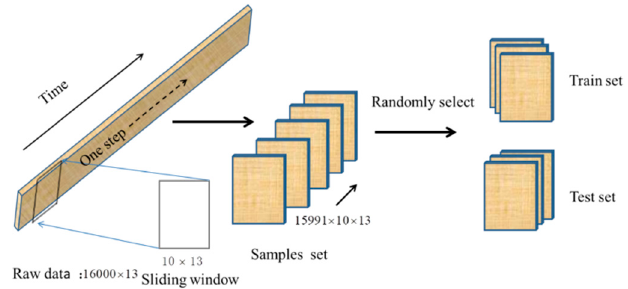
Figure 4. Sample acquisition. Table 1. Samples of the datasets A, B, and C.